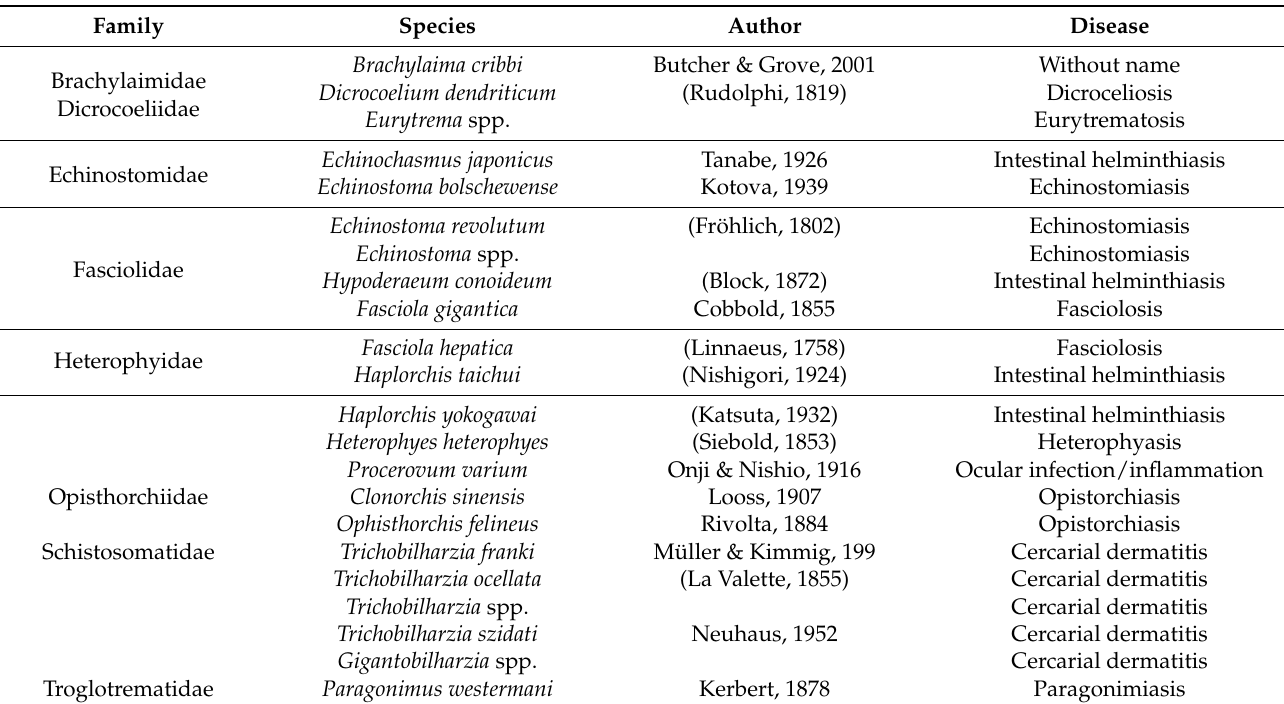
Table 1. Diversity of digenean flukes that can parasitize